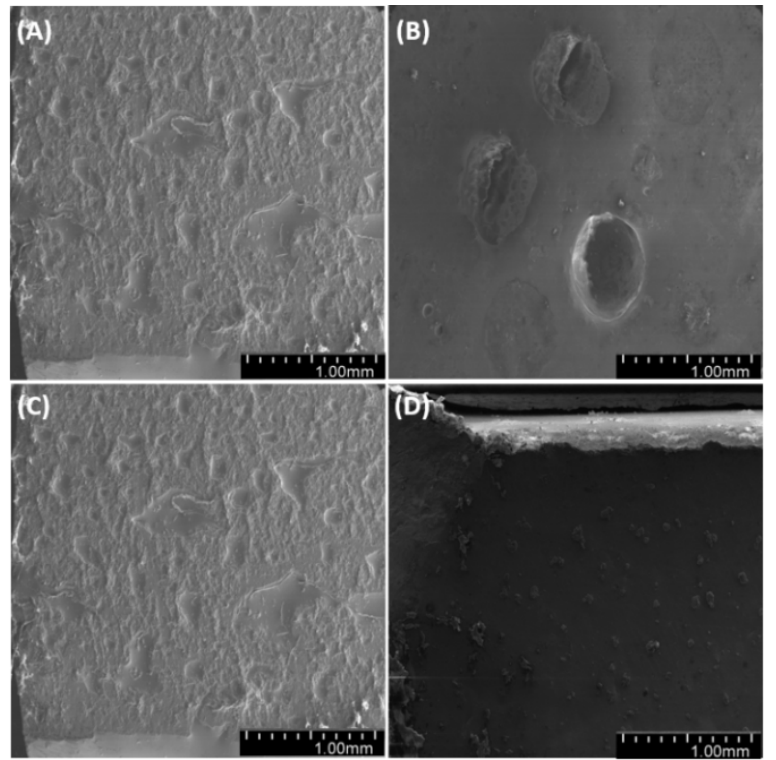
Figure 20. SEM images of the surface of samples with 48% vol. of diatoms ( A )—base deg, ( B )—base no deg, ( C )—fractionated deg, ( D )—fractionated no deg.